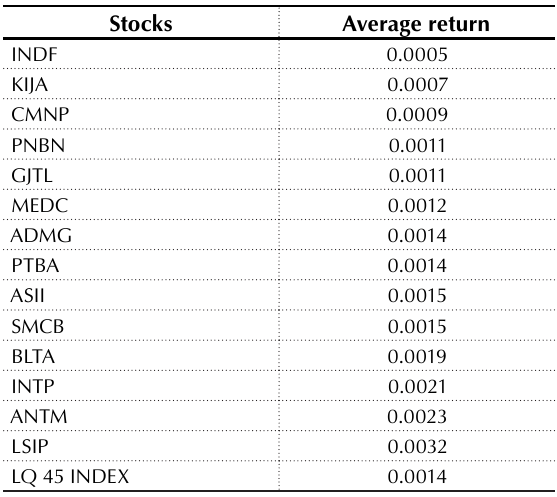
Table 1. Average return for each LQ 45 stock